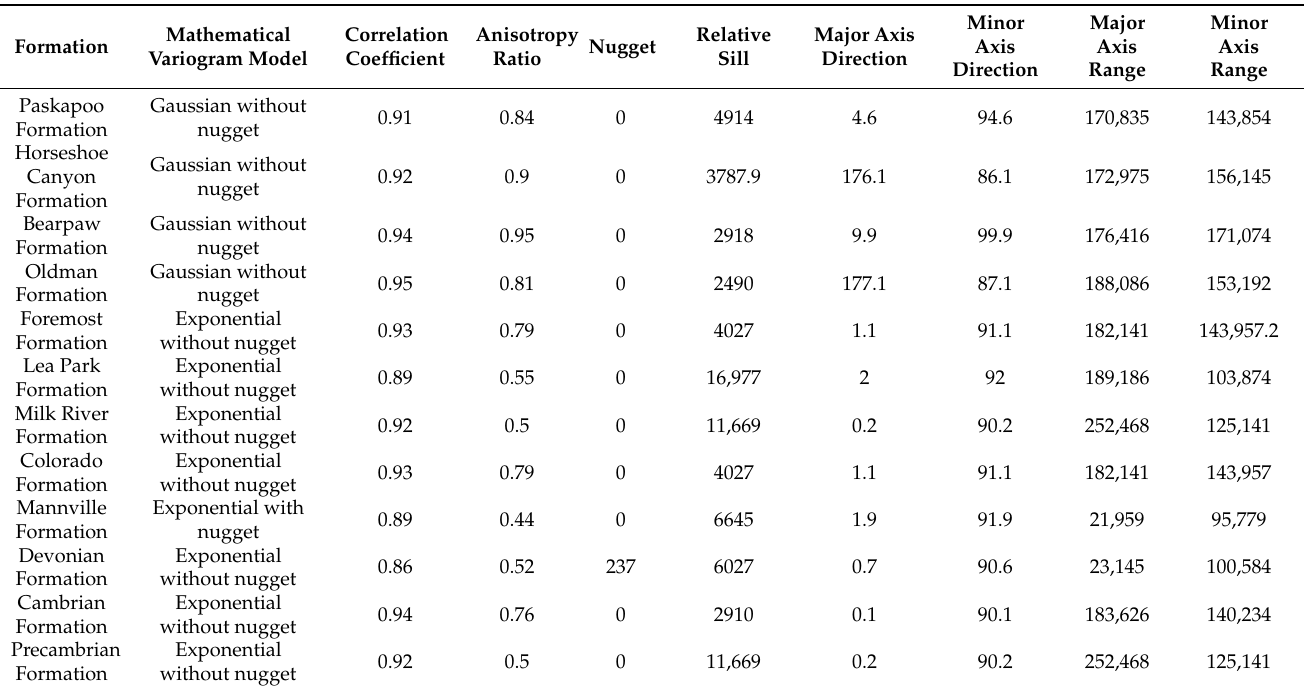
Table 3. Variogram characteristics for each modeled geological